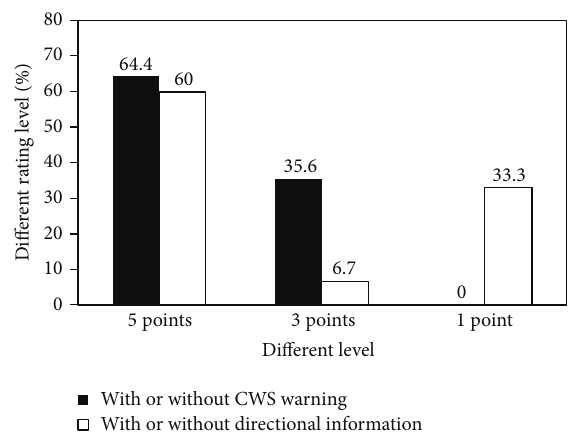
Figure 6: Results of subjective ratings of different warning condi- tions. (note: 5 points indicates that CWS or directional information makes a big contribution to reducing traffic collisions; 3 points indicates a small contribution; 1 point indicates no